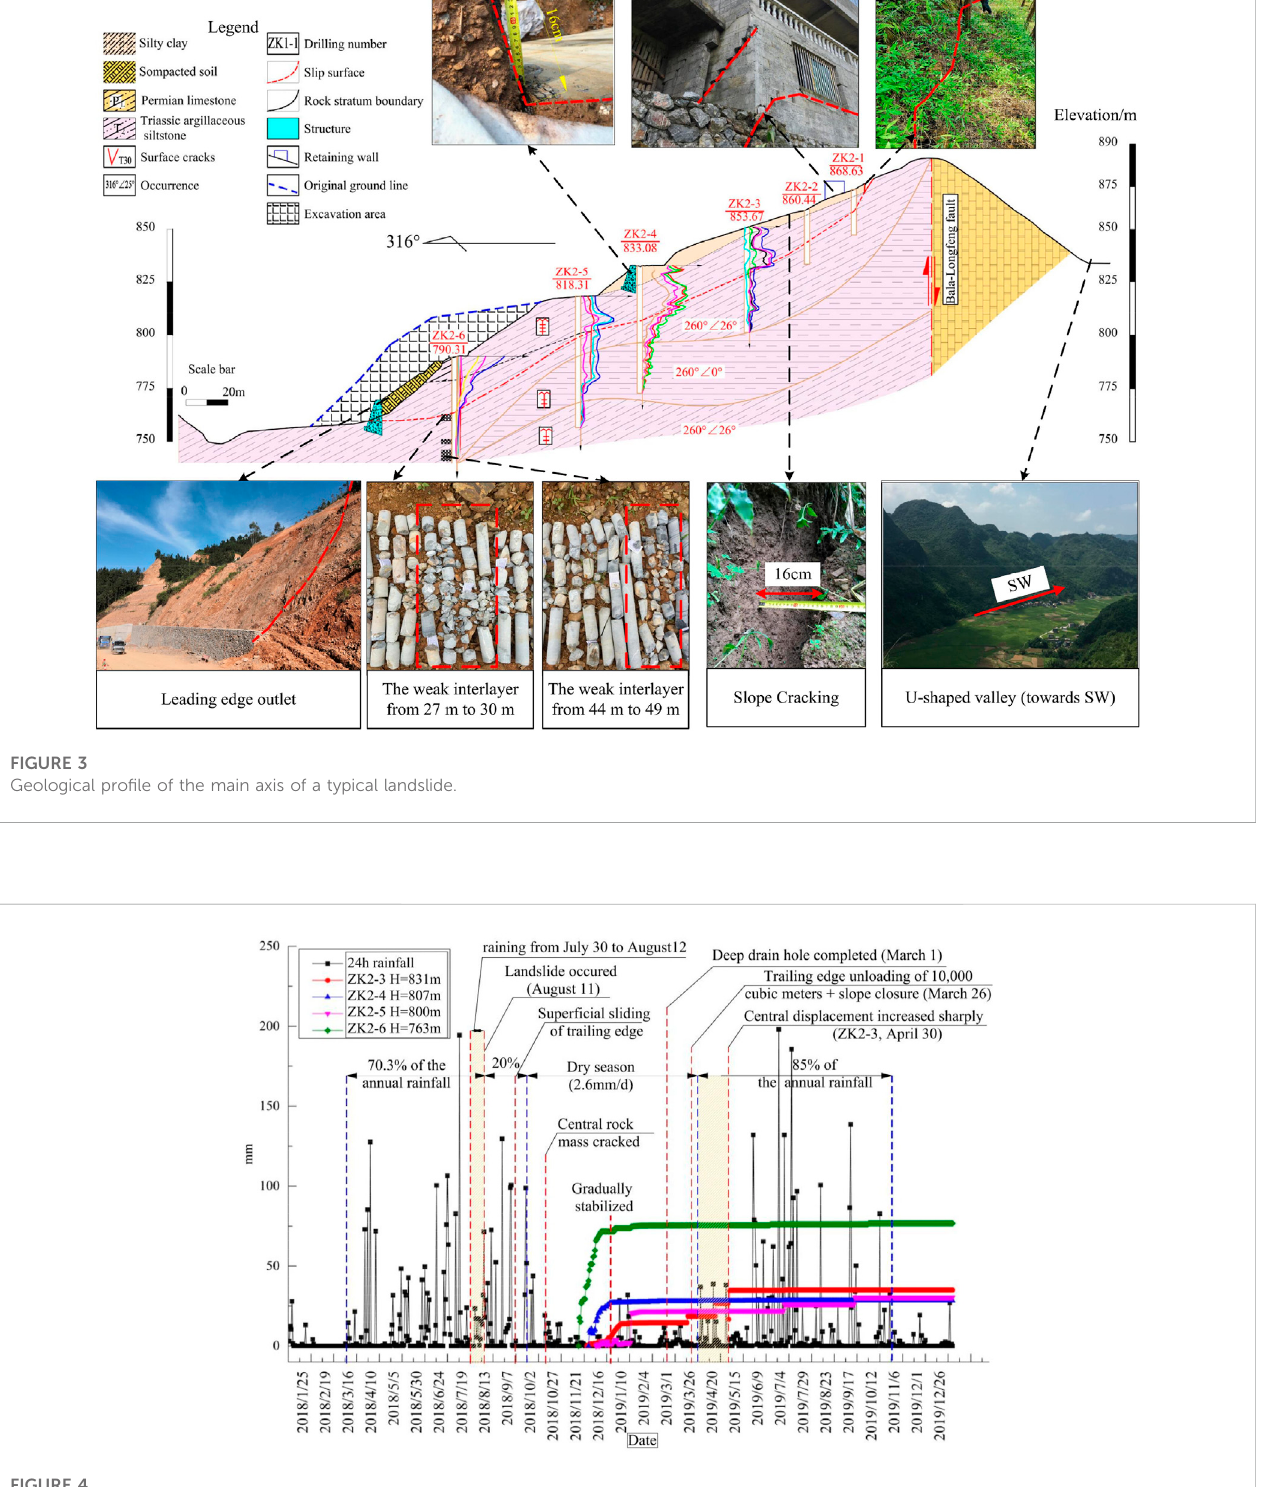
FIGURE 4 Daily rainfall and deep displacement data in the study